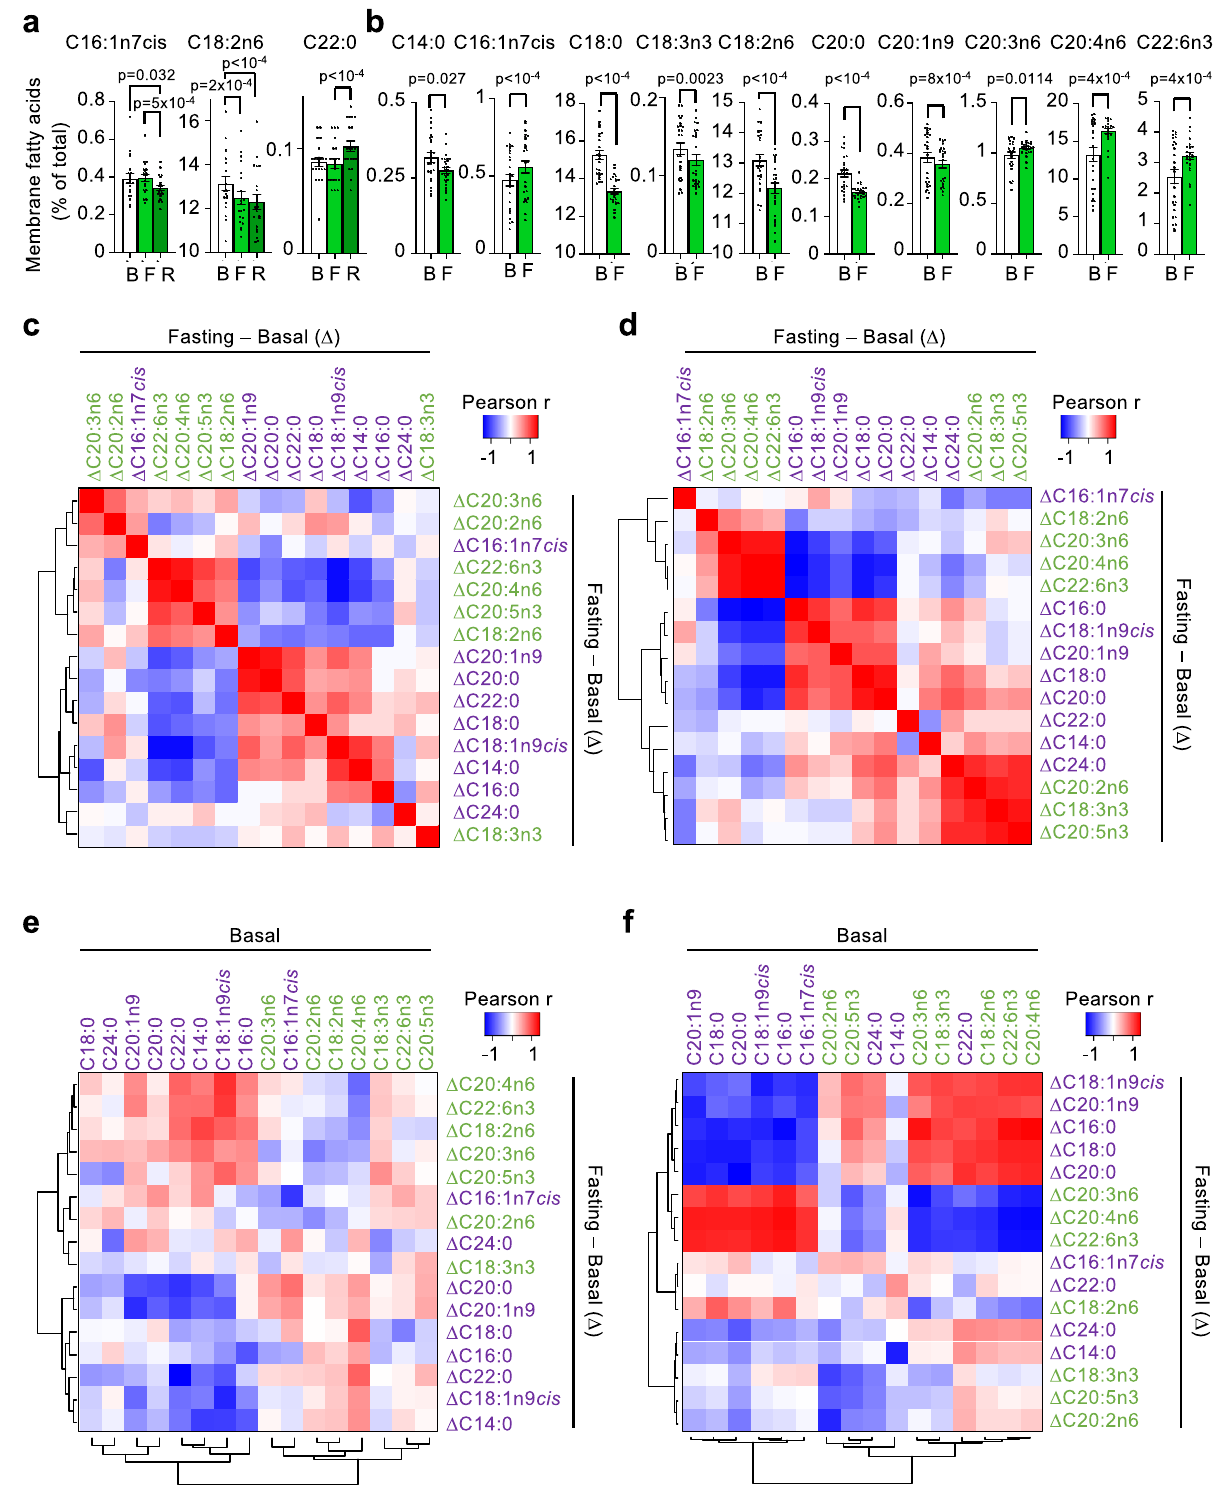
Fig.2|Short-termfastingelicitschangesinerythrocytemembranefattyacids. a , b Levels of the indicated fatty acids in erythrocyte membranes isolated at the indicatedtimesofthefastingexperiments(B:basal,after12hoffasting;F:after36hof fasting; R: after 12h of refeeding and 12h of fasting) in humans ( a , n =20) and mice ( b , n =26),expressedas%oftotalmembranefattyacids. c , d Heatmapsdepictingthe Pearson correlation r coef fi cients between changes (fasting minus basal, Δ ) of all the analyzed erythrocyte membrane fatty acids from human ( c ) or mice ( d ) samples. Red color indicates direct correlations, and blue color indicates indirect correlations. Saturated and monounsaturated fatty acids are written in purple; polyunsaturated